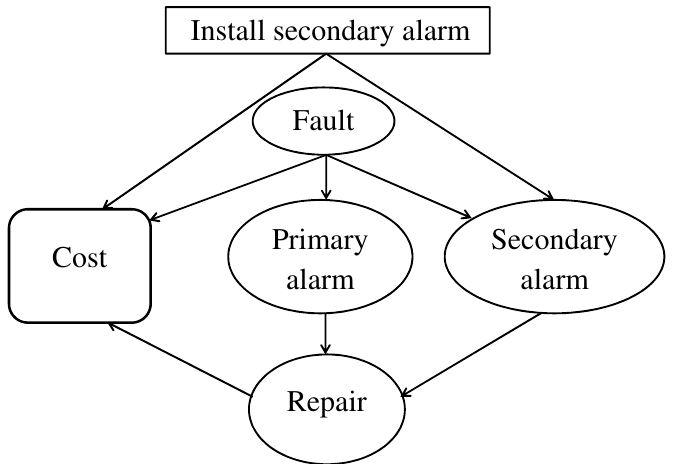
Figure 3. ID representing the problem of installing a secondary alarm signalling a machine